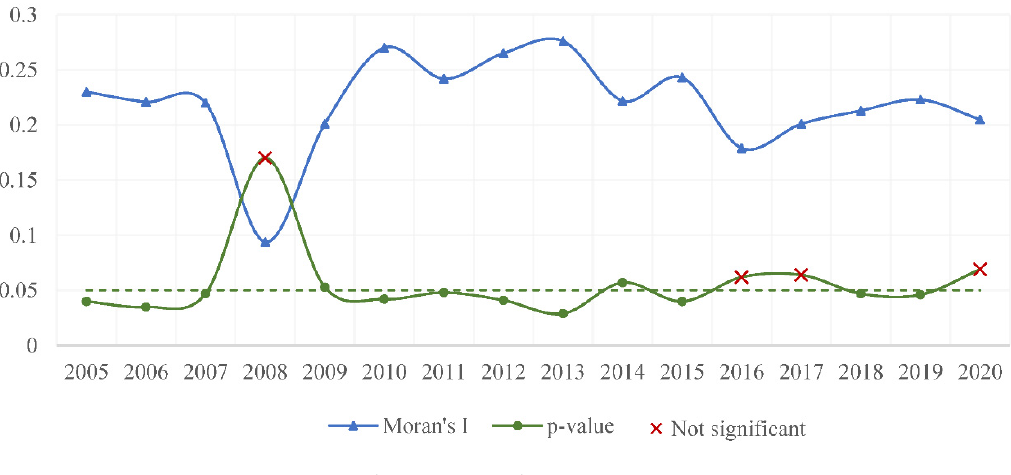
Figure 7. Autocorrelation test results.